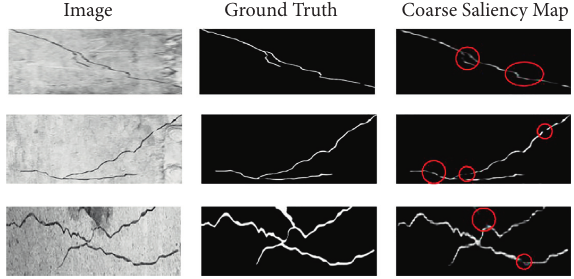
Figure 7: Coarse saliency map of